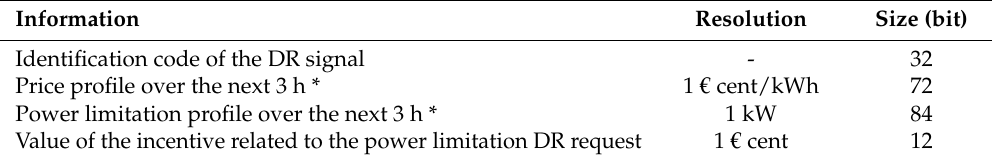
Table 4. List of information packed into each data sample transferred by the EV-MSP to EVs for the application of Vehicle-to-Grid (V2G) DR requests, per each monitored charging station. EV: